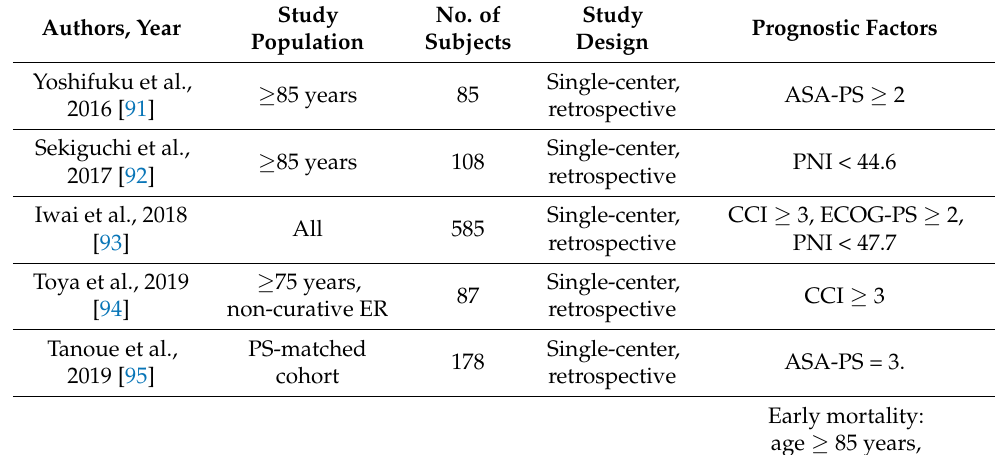
Table 4. Reports on prognostic factors in patients with ER for